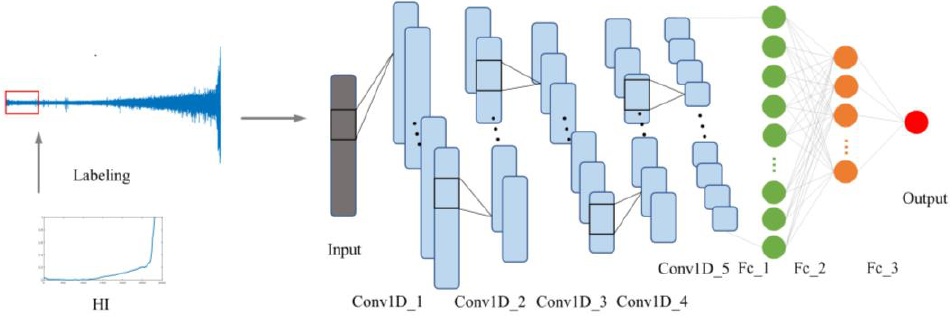
Figure 11. 1D-CNN structure diagram.